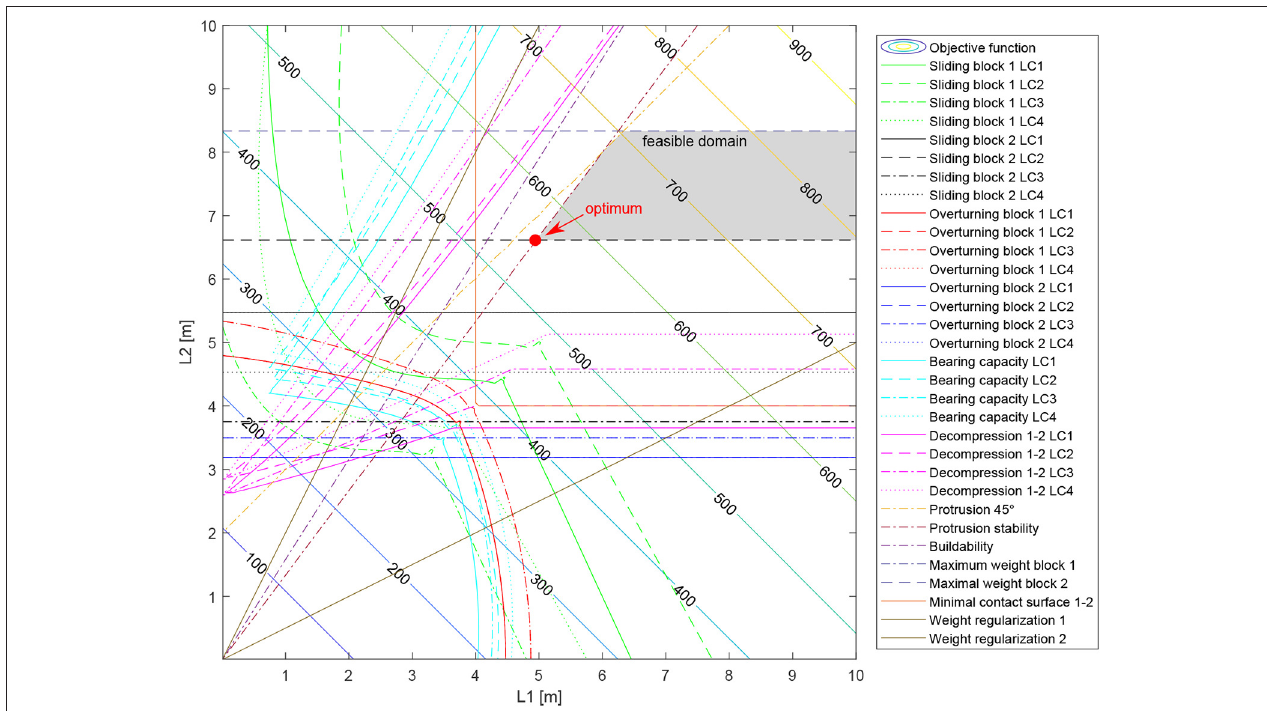
FIGURE 5 | Contour plot of the objective function for the 2-block wall as a function of the design variables L 1 and L 2 . The constraints, the feasible domain, and the optimum are also indicated.